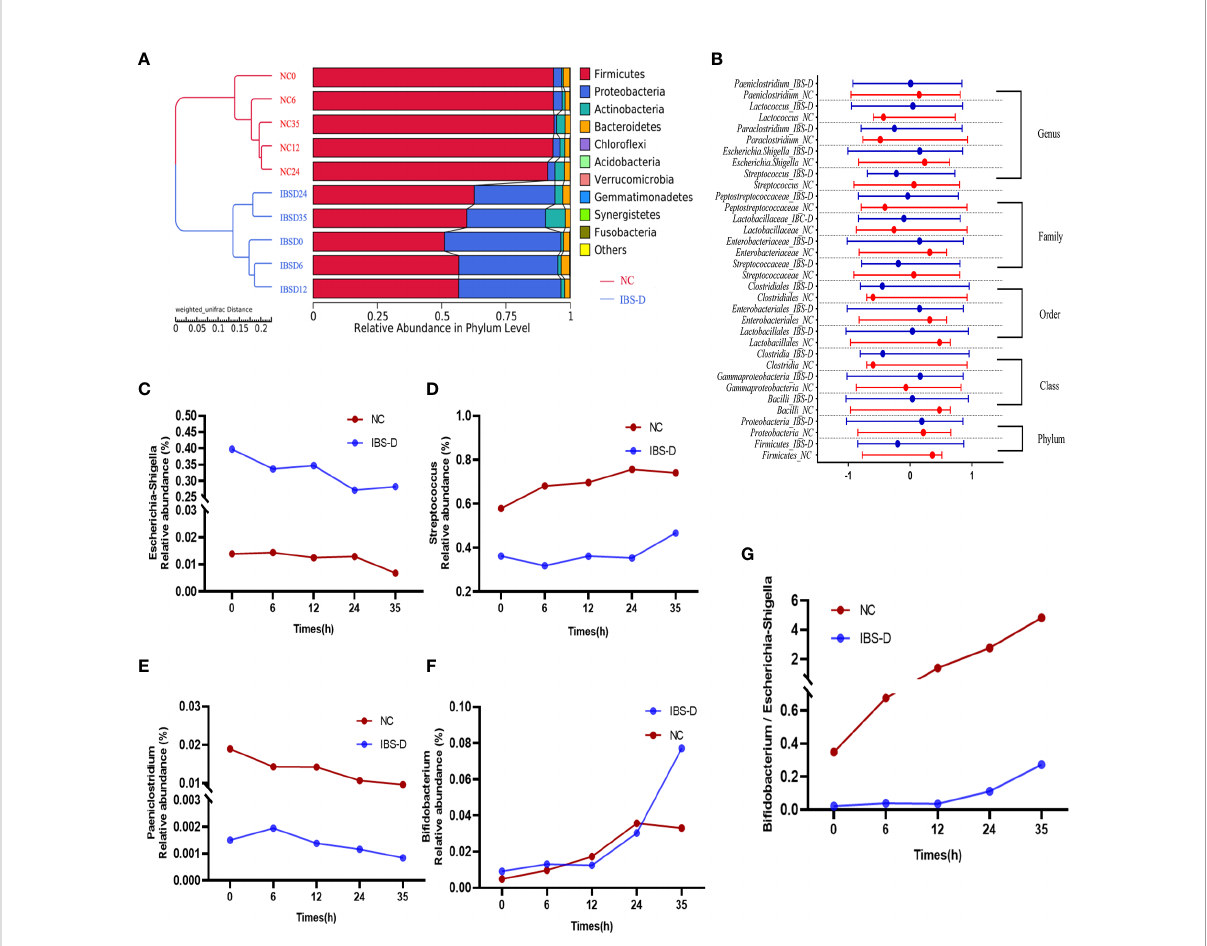
FIGURE 2 SJZD restored the dysbiotic intestinal microbiota of IBS-D subjects. (A) The unweighted pair-group method with arithmetic mean (UPGMA) clustering tree. (B) The Zscores of biomarkers at different taxa. The nodes in the graph show the median and interquartile ranges. Zscore = (x – m )/ s (x: relative abundance of known bacteria, s : standard difference, m : average value). (C-F) Time series of relative abundances of Escherichia-Shigella (C) , Streptococcus (D) , Paeniclostridium (E) , and Bi fi dobacterium (F) . (G) Bi fi dobacterium to Escherichia-Shigella ratio. IBS- D: IBS-D group. NC: Normal controls. The Arabic numbers 0~35 indicate the coculture times (hours) of SJZD with the microbiota. SJZD: Si- Jun-Zi Decoction. IBS-D: diarrhea-predominant irritable bowel